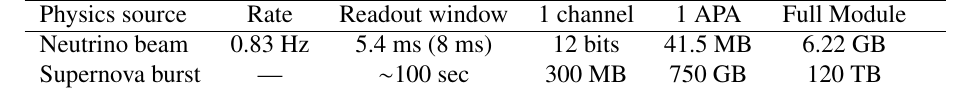
Table 1. Expected readout windows and corresponding data rates for neutrino beam and supernova physics scenarios [1]. The readout windows for neutrino-beam running are separately specified for